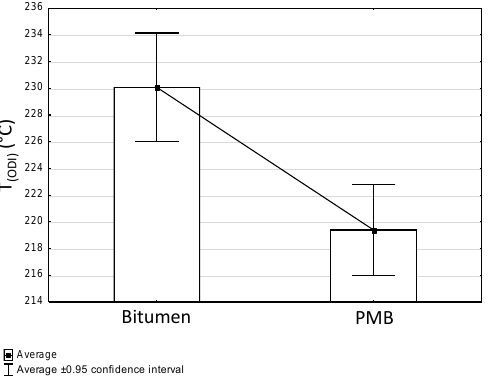
Figure 10. Difference in T (ODI) between road bitumens and polymer modified bitumens (PMB) — ANOVA.